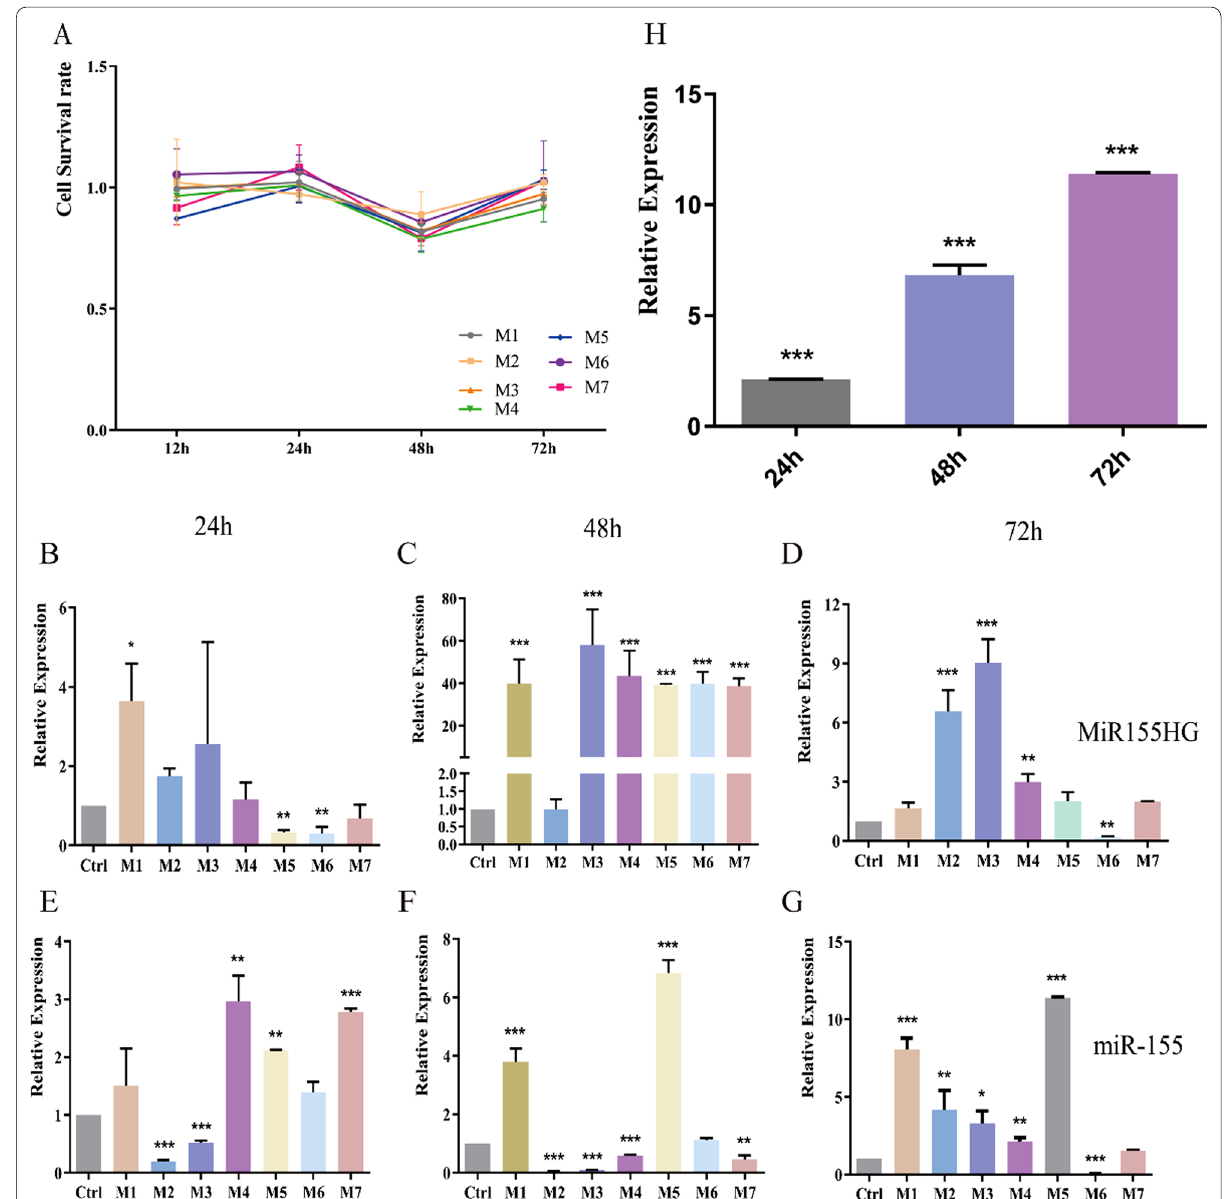
Fig. 4 A NFs M1–M7 were prepared from different saRNA template sequences. Cell survival rates after 12, 24, 48, or 72 h were determined using the CCK-8 assay. P > 0.05 vs Ctrl. B – D Relative MiR155HG expression levels at 24 h, 48 h, or 72 h after treatment of HUVECs with NFs M1–M7. E – G Relative miR-155 expression levels at 24 h, 48 h, or 72 h after treatment of HUVECs with NFs M1–M7 (*P < 0.05 vs Ctrl; **P < 0.01 vs Ctrl; ***P < 0.001 vs Ctrl). (H) Relative miR-155 expression in HUVECs treated with M5 for 24 h, 48 h, or 72 h (*P < 0.05 vs Ctrl; **P < 0.01 vs Ctrl; ***P < 0.001 vs